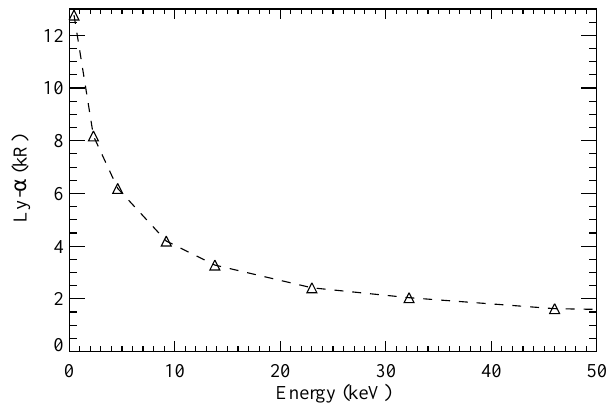
Fig. 1. Variation of the Ly- α emission rate for a unit (1mW/m 2 ) incident proton energy flux as a function of the mean initial energy of the protons. The curve was calculated for a kappa energy distri- bution and a nadir observation from outside the